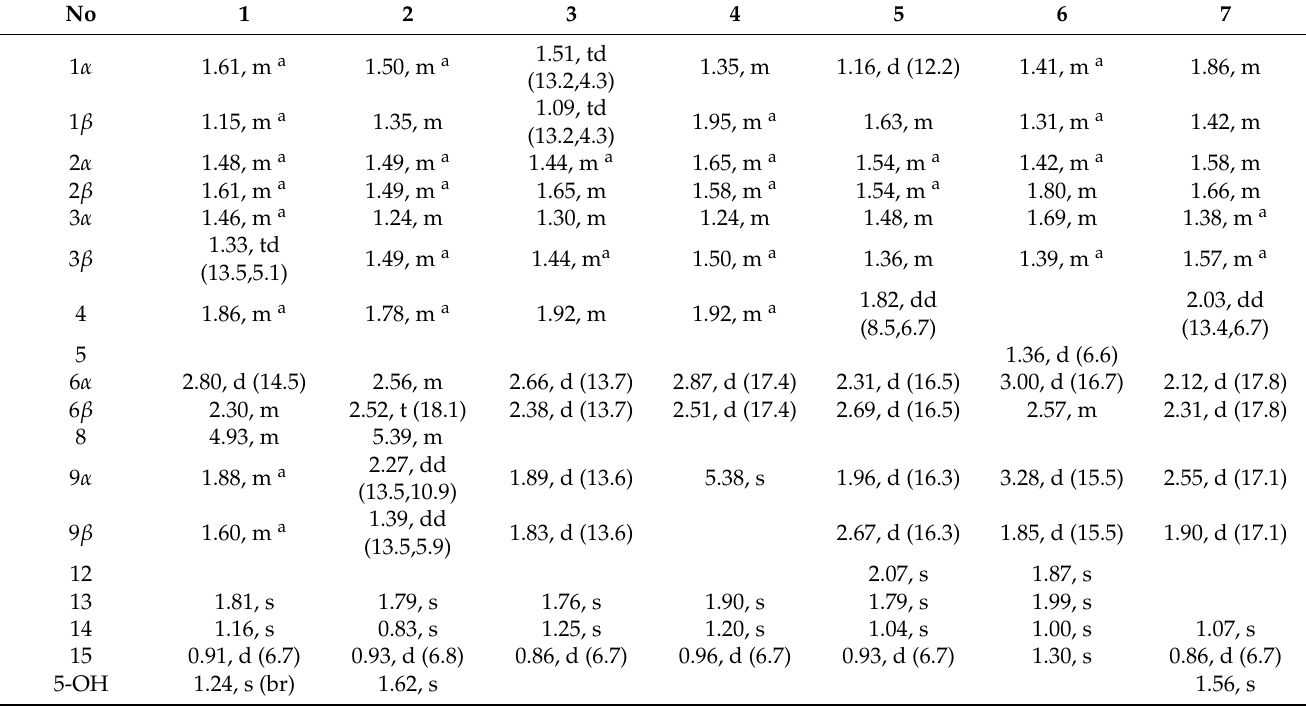
Table 1. 1 H (500 MHz) NMR data for compounds 1 – 7 in CDCl 3 ( δ H in ppm, J in Hz).